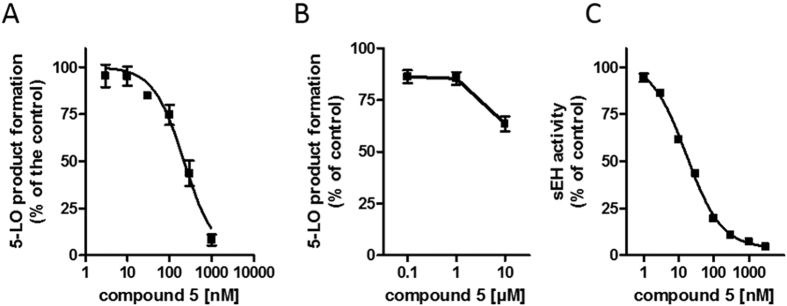
Concentration-response curves for inhibition of FLAP-dependent 5-LO product formation and sEH activity.(A) FLAP-dependent 5-LO product formation in intact PMNL (B) inhibition of 5-LO activity, cell-free assays, and (C) inhibition of sEH activity by compound 5. Data, means ± SEM, n = 4.